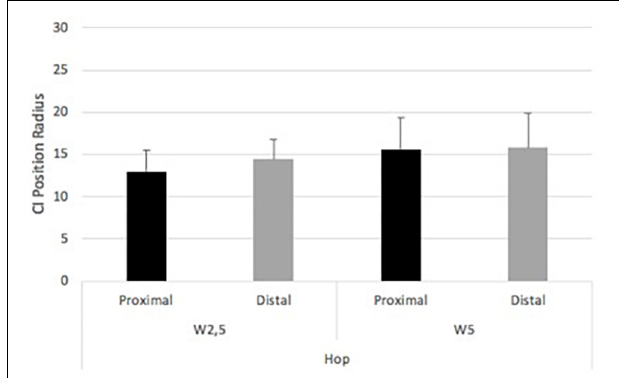
FIGURE 8 | Experiment 2. Complexity Index position radius within foci and between wall distances in the hop task.